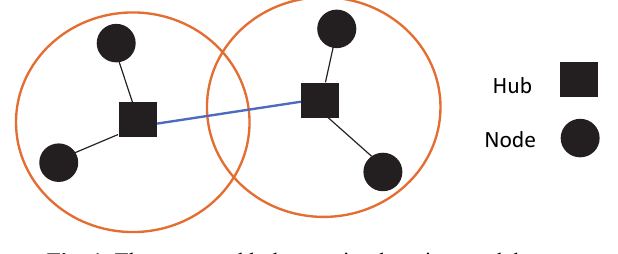
Fig. 1 . The proposed hub covering location